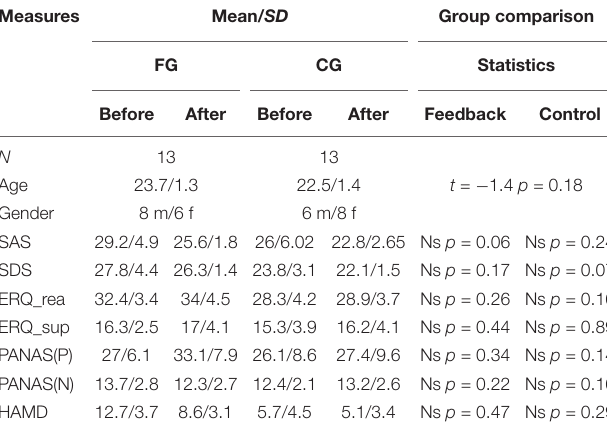
TABLE 1 | Questionnaire score characteristics (mean ±